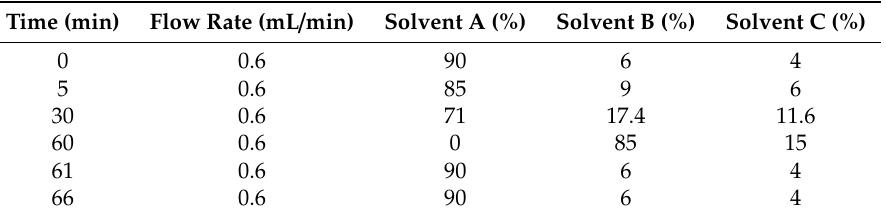
Table 9. Solvent system of high-performance liquid chromatography (HPLC) to identify phenolic acids and flavonoids in sacred lotus